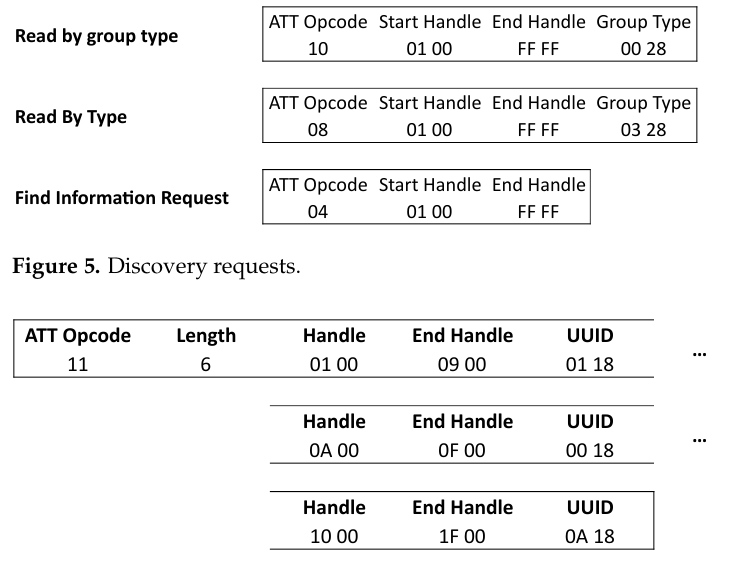
Figure 6. Service discovery response.